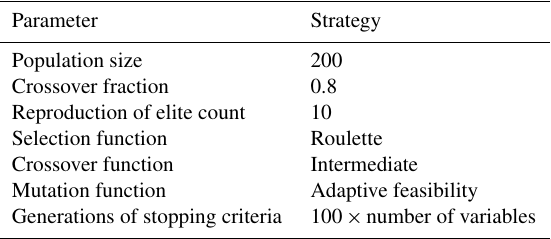
Table 1. Parameters of the genetic